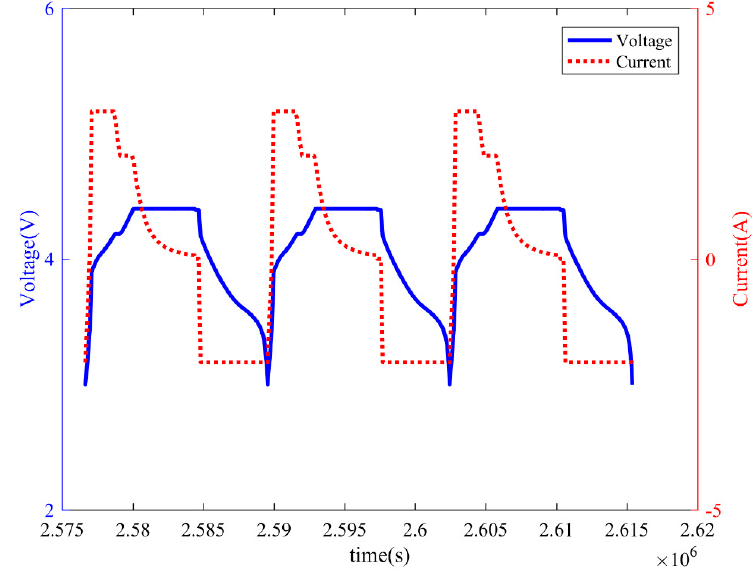
Figure 3. Repetitive charging and discharging profiles.